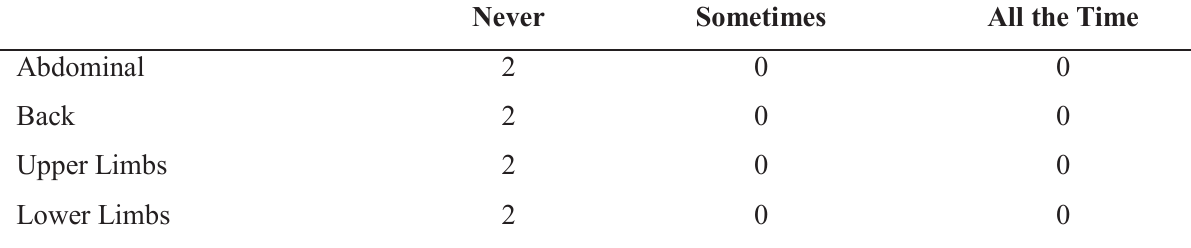
Table 5 - Surgical Assistant on Post-Operative Muscular Discomfort Questionnaire.